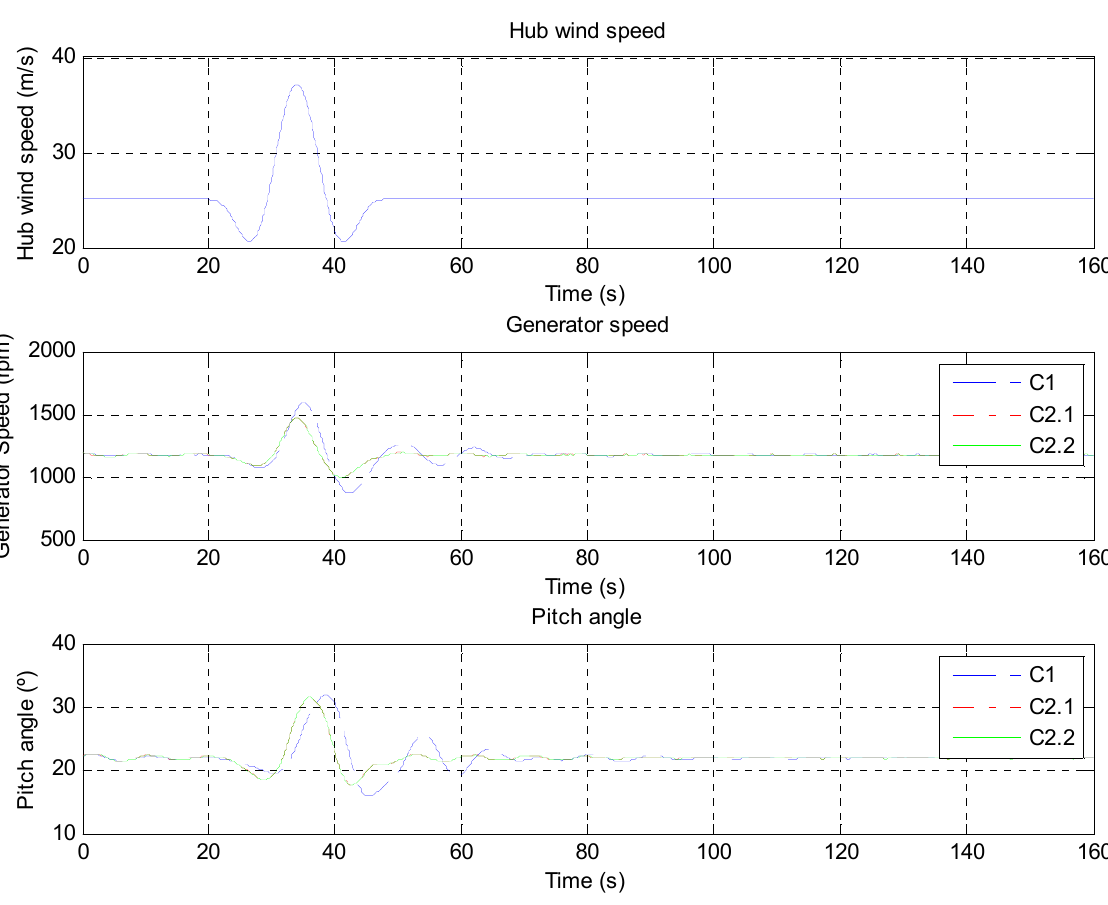
Figure 20. Vout-p extreme gust